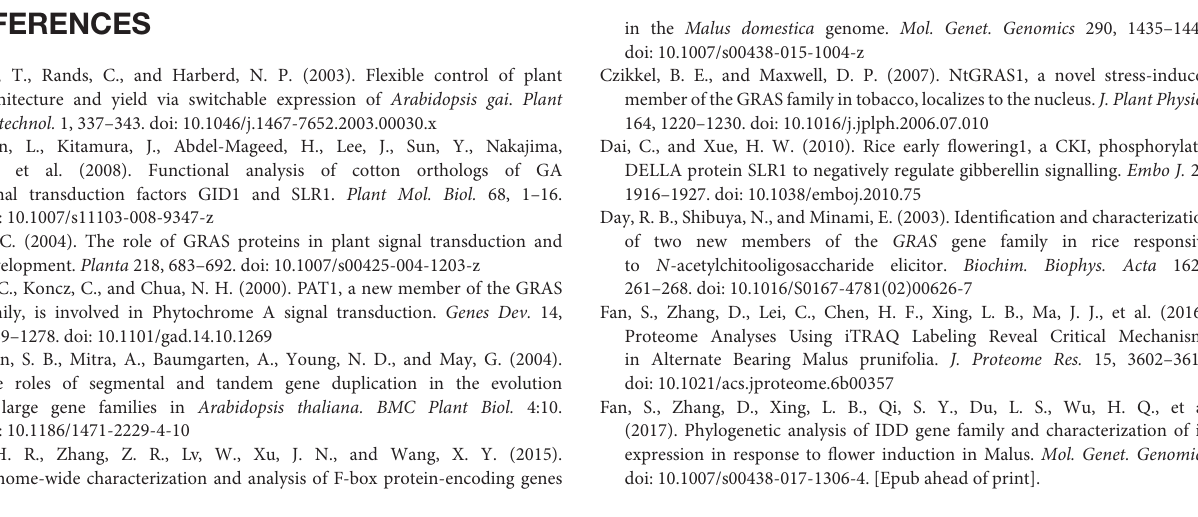
Figure S2 | MdGRAS gene structures. MdGRAS gene exon–intron composition. Red boxes and black lines represent exons and introns, respectively. Figure S3 | Alignment of DELLA subfamily members in apple and Arabidopsis. Figure S4 | Heat map showing the transcript levels of MdGRAS genes during flower induction. Transcript levels of GRAS genes in the buds of “Nagafu No. 2” and “Yanfu No. 6” were investigated during flower induction. Samples were collected three times at the early stage (ES), middle stage (MS) and later stages (LS) of flower induction. Figure S5 | Expression of candidate MdGRAS genes in GA-treated buds. Samples were collected three times at ES, MS and LS in 2014, which was consistent with 40, 50, and 70 DAFB in 2016. Each value represents the mean ± standard error of three replicates. Figure S6 | Expression of candidate MdGRAS genes in 6BA-treated buds. Samples were collected three times at ES, MS and LS in 2013, which was consistent with 30, 50, and 80 DAFB in 2016. Each value represents the mean ± standard error of three replicates. Figure S7 | Predicted cis -elements in the promoter regions of the candidate MdGRAS genes. The upstream 1.5 kb promoter sequences were analyzed.